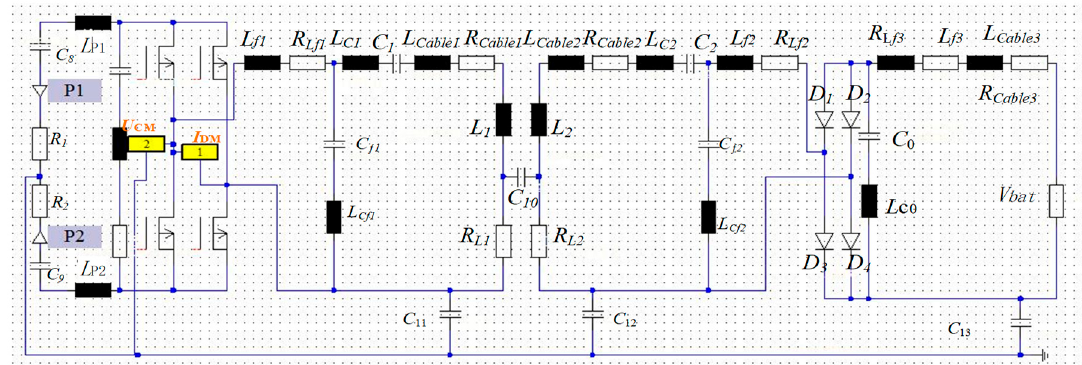
Figure 9. Computer Simulation Technology (CST) model for EMI emission.